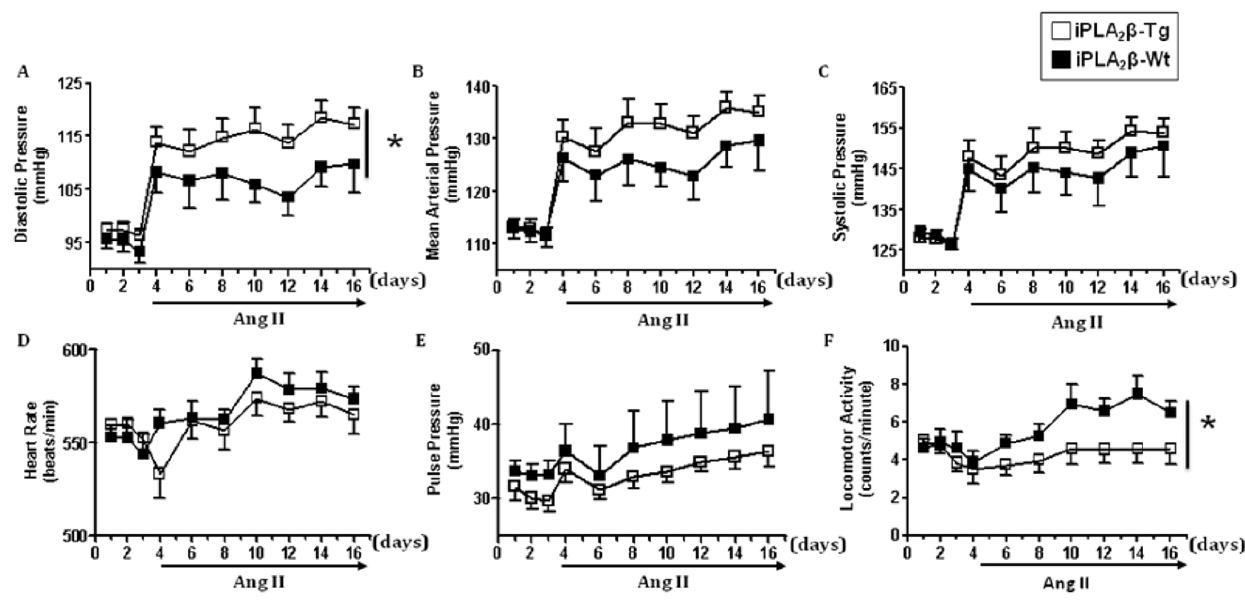
Figure 1. Enhanced diastolic blood pressure increase in iPLA 2 b -Tg mice in response to Ang II infusion. Blood pressure was measured in 13-wk old male, iPLA 2 b -Wt and iPLA 2 b -Tg mice by radiotelemetry. 24 h averages of systolic ( A ), diastolic ( B ), and mean arterial pressure ( C ), heart rate ( D ), pulse pressure ( E ), and locomotor activity ( F ) were collected prior to and during Ang II infusion (500 ng/kg/min, 14 days). n=8; *: p , 0.05 by two- way ANOVA with repeated